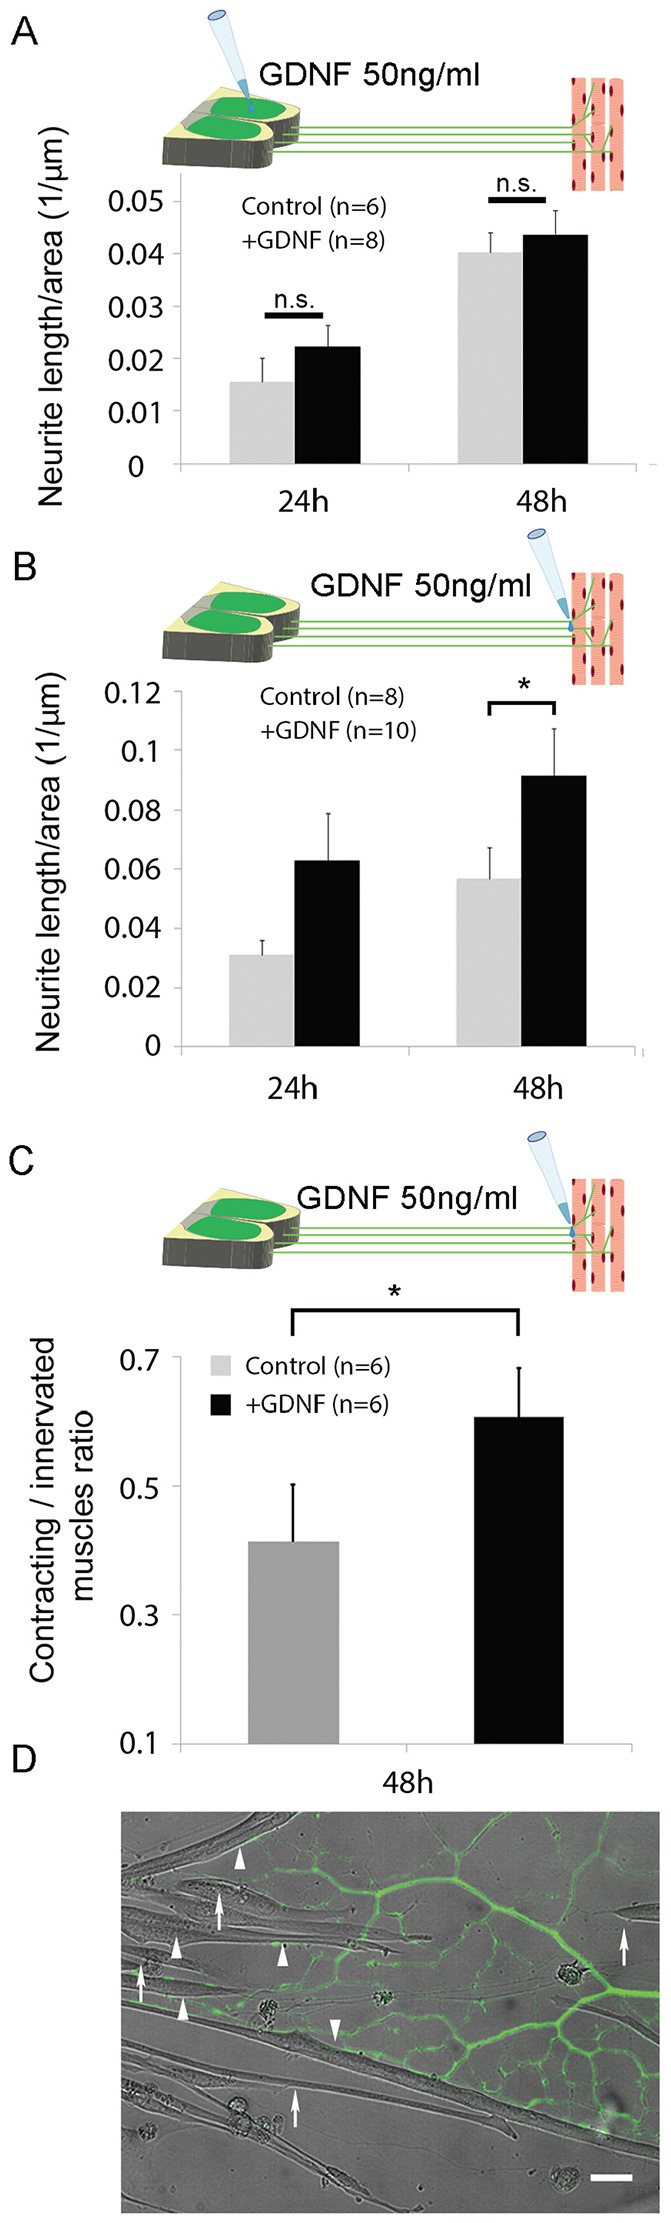
GDNF facilitates axonal growth and muscle innervation when added specifically to the axonal/muscle compartment. (A,B) Mean axonal length in the muscle compartment normalized to the area of measurement in the chamber treated with GDNF in (A) the neuronal cell body or (B) muscle compartments compared to the control. Two images of each co-culture muscle compartment from two independent experiments were pooled and analyzed. Data show the mean±s.e.m.; *P<0.05; n.s., non-significant (one-tailed Student's t-test). (C) Mean rate of functionally innervated muscles, measured according to their contractile behavior in the distal side GDNF treatment condition compared to the control, at 48 h after treatment. See Materials and Methods for further details. Data were taken from two independent experiments and show the mean±s.e.m.; *P<0.05 (one-tailed Student's t-test). (D) Representative epifluorescent and brightfield images, taken with a 20× objective, of myotubes innervated by HB9::GFP-expressing (green) axons that were not contracting (arrows) and myotubes displaying typical innervation-induced contraction (arrowheads). Scale bar: 25 µm.